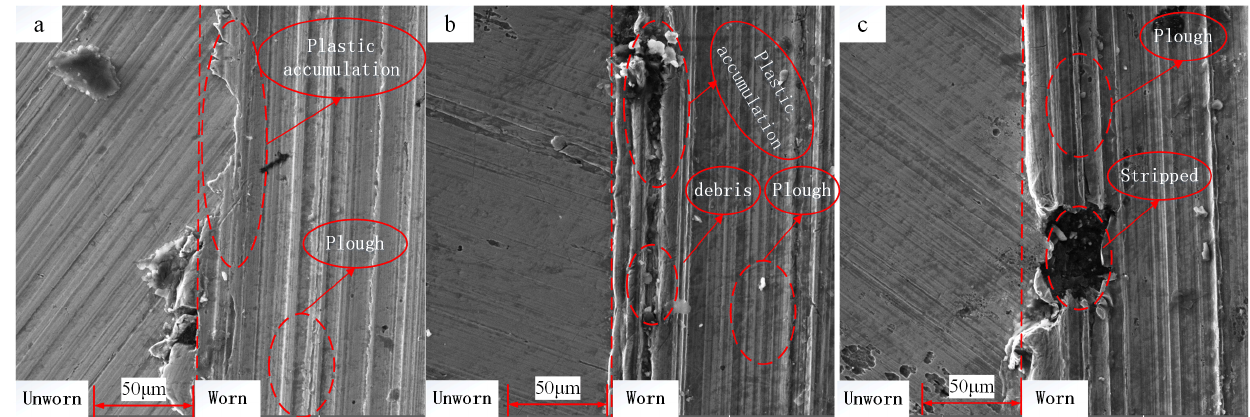
Figure 11. The surface morphology of QT350-22L sliding contact with LC2-1. ( a ) 25 °C ( b ) −2 0 °C ( c ) −4 0 °C.